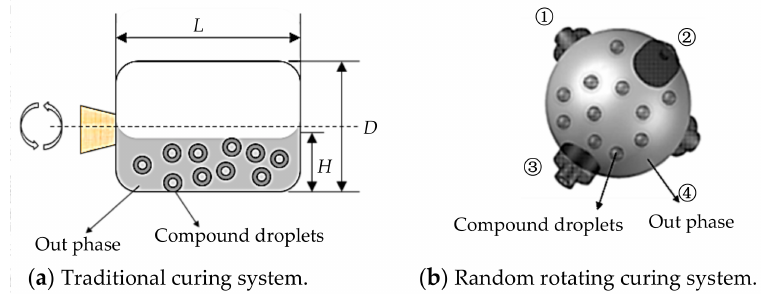
Figure 2. Schematic diagram of the curing system. ( a ) In the traditional curing system, the container rotates in one direction around the center shaft. The lengths of the container are D and L , respectively, and the liquid level is H ; ( b ) In the random rotating curing system, the rotation of the container is controlled by the four axis ball grinding apparatus 1 (cid:79) , 2 (cid:79) , 3 (cid:79) and 4 (cid:79) .